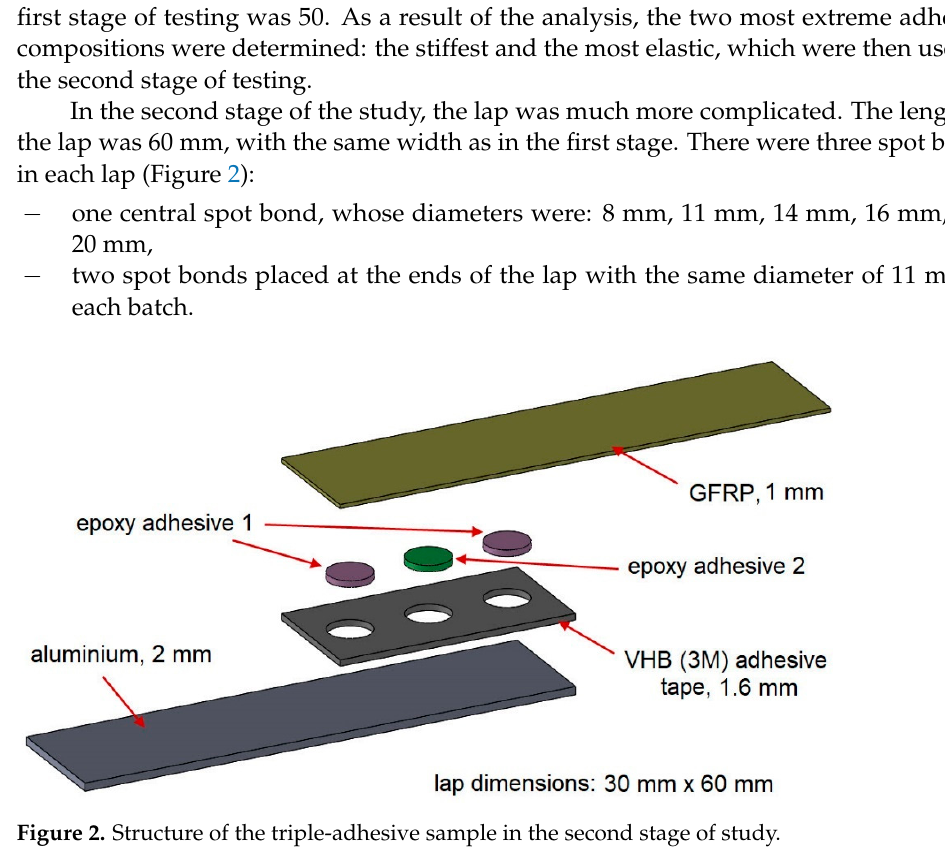
Figure 2. Structure of the triple-adhesive sample in the second stage of study.